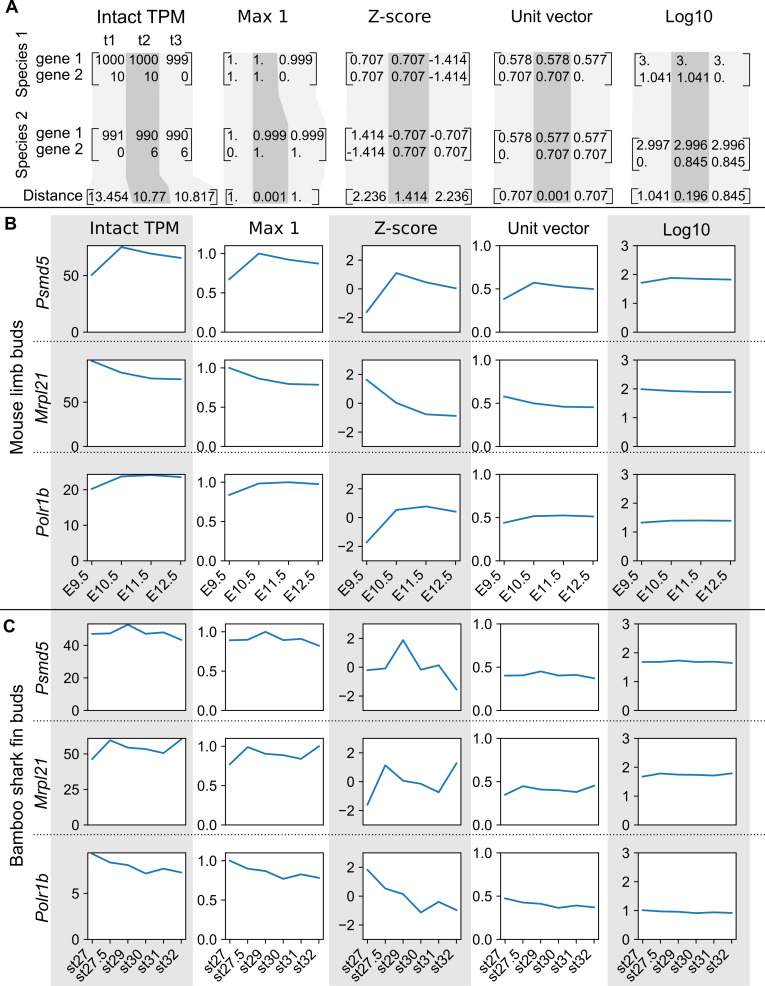
The effect of scaling methods to housekeeping genes.(A) A simple example for comparing expression distances between two species. Species 1 and 2 are imaginery simple species that have two genes (genes 1 and 2) and three developmental time points (t1, t2, and t3). Distances in the bottom are the Euclidean distance between two species at each stage. (B, C) Housekeeping gene expressions with intact TPM values and different scaling methods in mouse limb buds (B) and bambooshark fin buds (C). Intact TPM, TPM values without any scaling methods; Max 1, TPM values were scaled by setting the highest TPM in each gene of each species to ‘1’; Z-score, the mean expression value was subtracted from each expression value and each result was then divided by the standard deviation; Unit vector, expression values were divided by the norm; Log10, log10 transformation. These housekeeping genes are listed in both a human housekeeping gene list (https://www.tau.ac.il/~elieis/HKG/HK_genes.txt) and the BUSCO data set (thus these genes are likely conserved in most vertebrates). Note that although the expression values of the housekeeping genes were almost constant during development, Z-score scaling amplifies subtle differences between stages. In addition, intact TPM values were not readily comparable between limb buds and bamboo shark fin buds (e.g. the maximum value of POLR1B in mouse limb buds was roughly twice as high as that of bamboo shark fin buds). Error bars are not displayed.